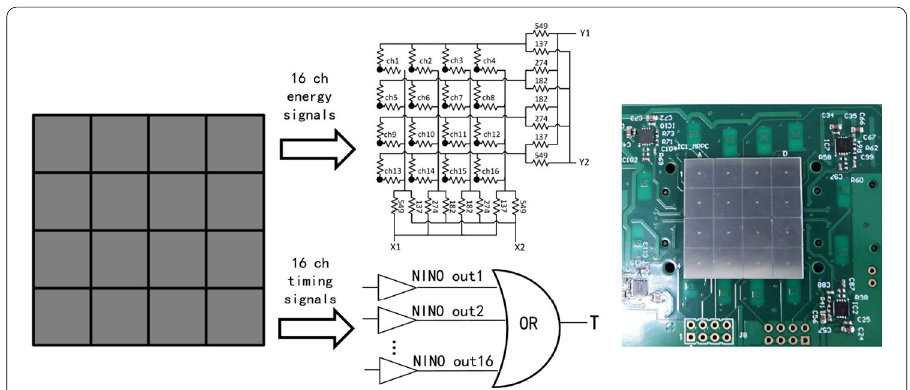
Fig. 3 (left) The schematic of the signal readout of a 4 readout circuit